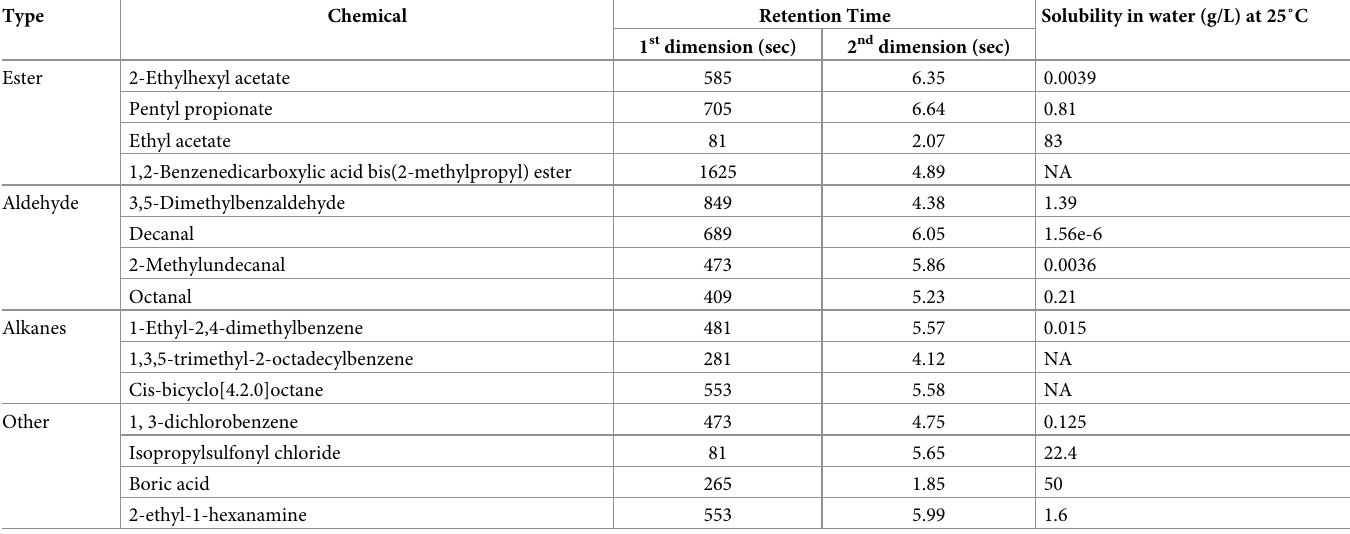
Table 1. Major VOCs produced from Listeria